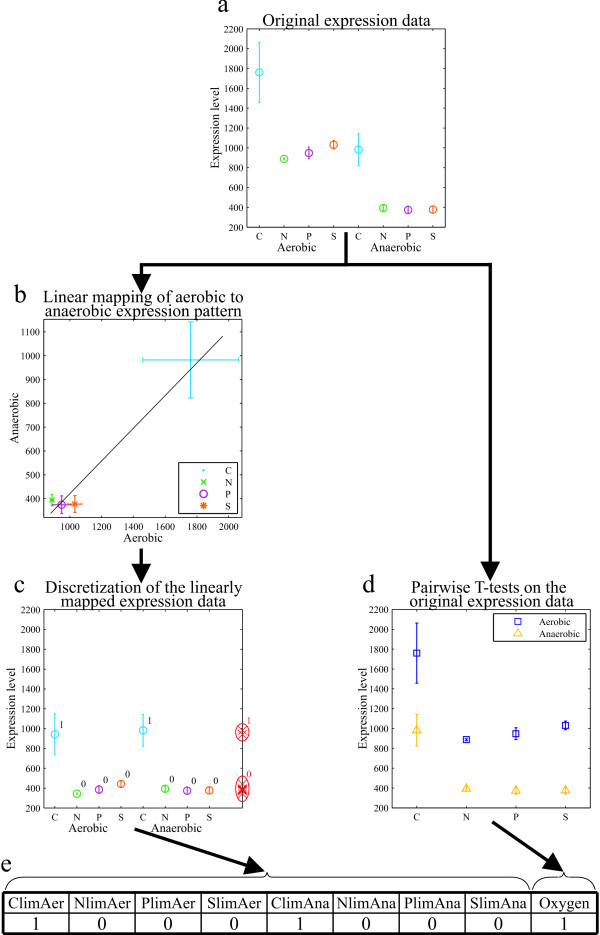
Procedure to derive the discretized representation of a gene. a) Examination of the expression levels under the eight cultivation conditions led to the observation that for many genes the expression pattern across the four nutrient limitations when grown aerobically is a scaled and offset version of its anaerobic counterpart. (Permutation tests were performed to confirm this notion (Additional file 3)). b) This "global oxygen effect", i.e. the effect that presence of oxygen has on the expression levels across all or most of the nutrient limitations, is modeled as a linear relationship and estimated using a regression strategy. c) The estimated regression parameters (slope and offset) are employed to isolate the oxygen effect by transforming the aerobic expression values. Discretization of this pattern allows for identification of up- or downregulation as a consequence of specific nutrient limitations and possible nutrient-limitation-specific effects of oxygen presence. d) Pairwise T-tests are performed to compare the original aerobic and anaerobic expression values for each nutrient limitation. The results of these tests are combined to detect possible consistent and significant higher or lower expression as a consequence of oxygen presence. e) The derived discrete representation of the expression of a gene is visualized in a nine-bit ternary (-1,0,1) vector.